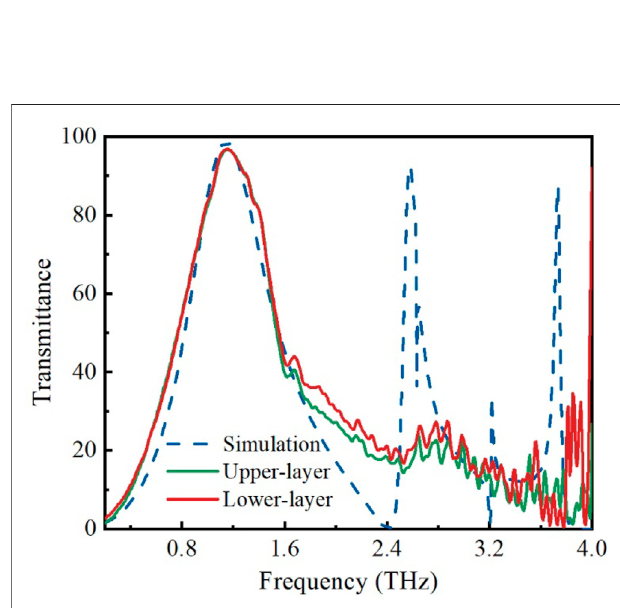
FIGURE 8 | Comparison for transmission spectra about the simulation results and two samples with the same set of parameters.